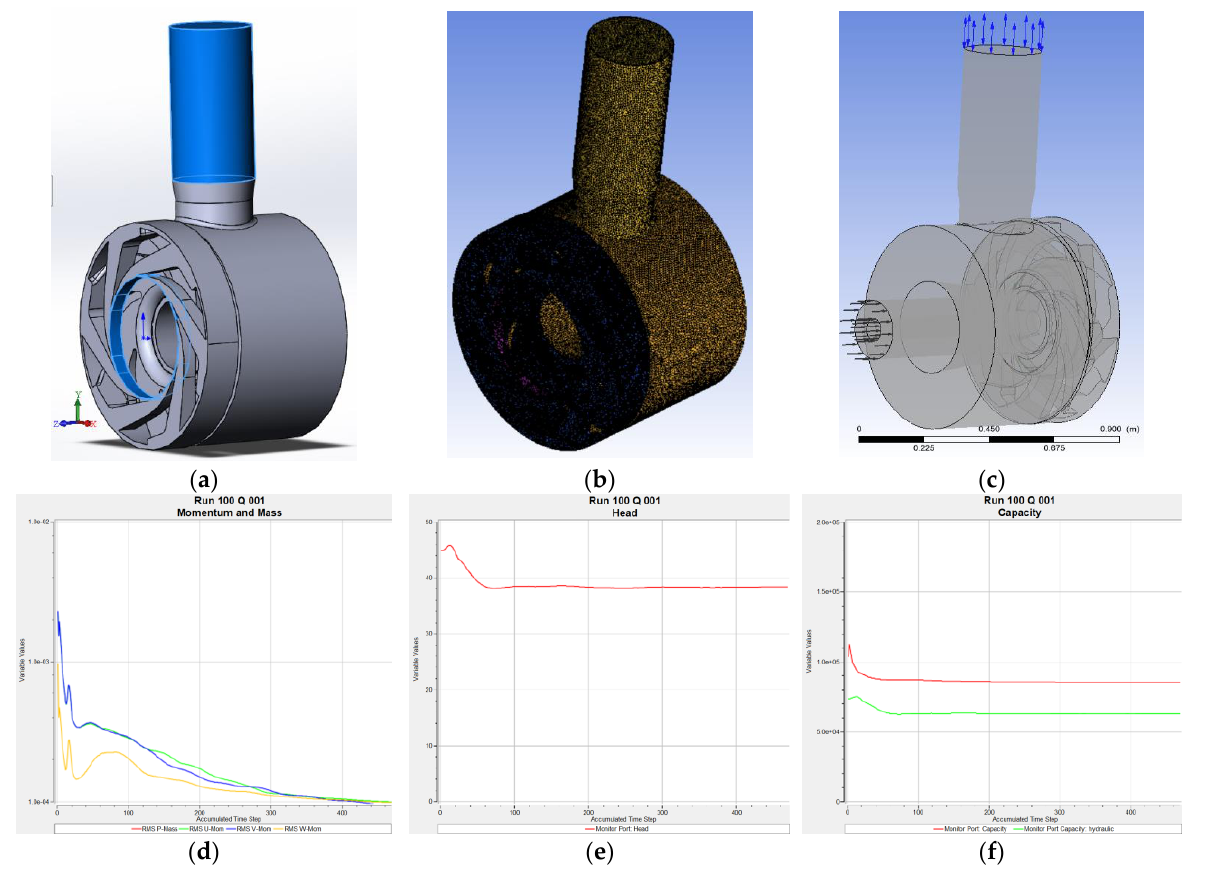
Figure 2. Preparation stages for the numerical simulations: ( a ) 3D model of the environment at the flowing part of the developed pump ACNA 600-35; ( b ) calculation mesh; ( c ) setting of interfaces during the numerical study; ( d ) mass and moments convergence parameters; ( e ) pressure convergence parameters; ( f ) convergence of output power and power consumption.